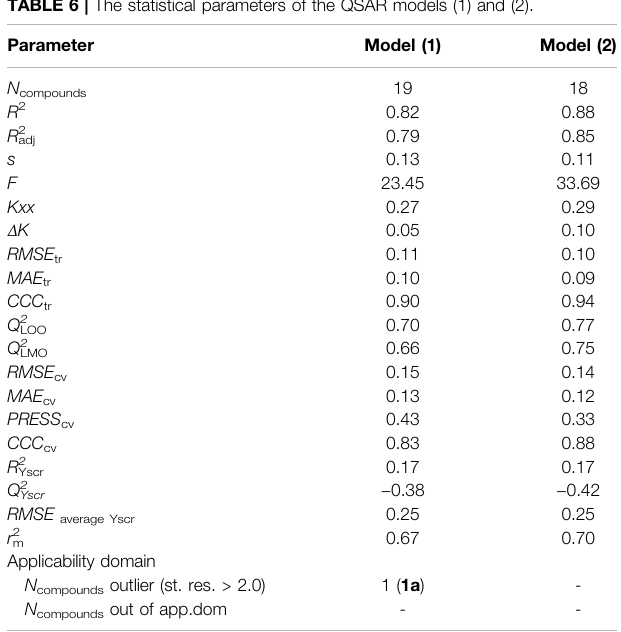
LOO(theleave-oneout);LMO(theleave-moreout); R 2 (coef fi cientofdetermination); R 2 adj (adjusted coef fi cient of determination); s (standard deviation of regression); F (Fisher ratio); Kxx (global correlation among descriptors); Δ K (global correlation among descriptors); tr =trainingset; cv =cross-validation); Yscr =Y-scramble; RMSE ,root-mean- squareerror; MAE ,meanabsoluteerror;CCC,concordancecorrelationcoef fi cient; Q 2 = variance explained; PRESS, predictive error sum of squares; r 2 m = absolute difference between the R 2 and R 2 0 (determination coef fi cients with and without intercept); h * (warning leverage for the applicability domain of the model).